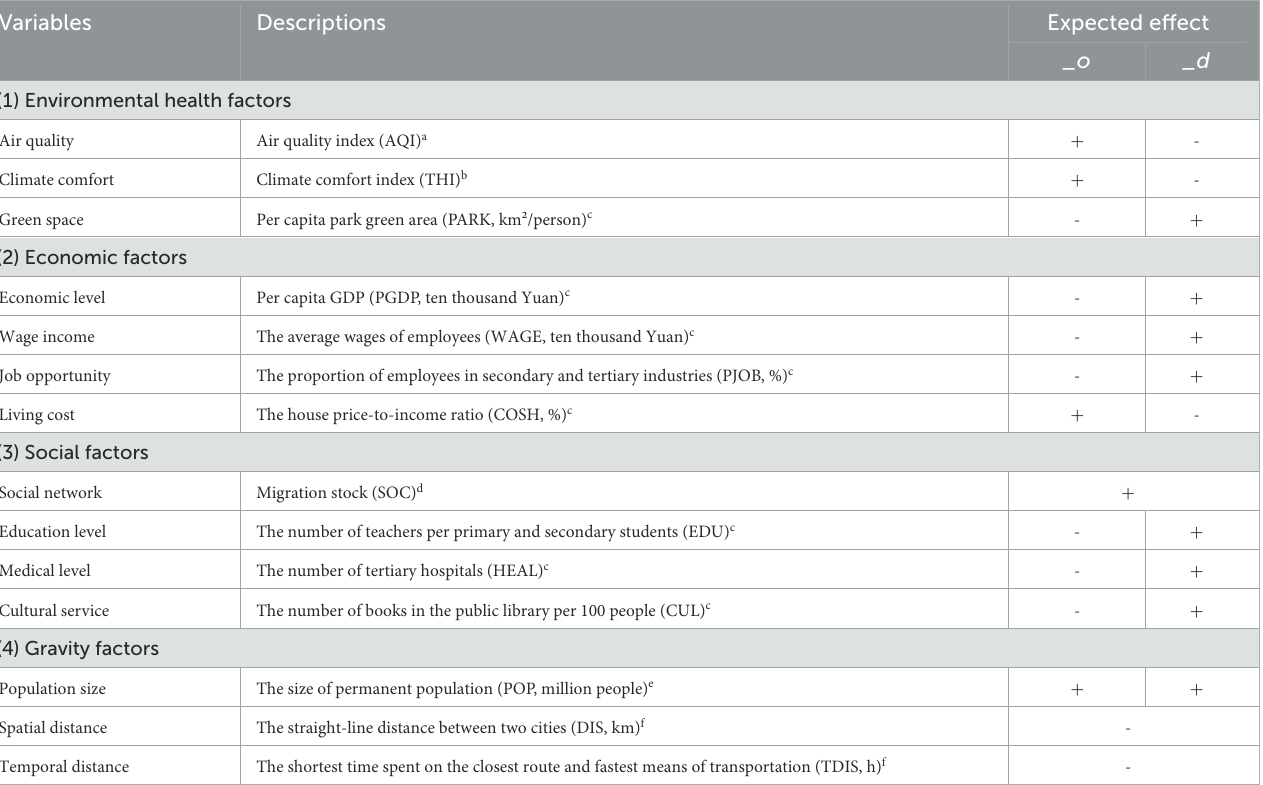
TABLE 1 The variables system of influencing factors of inter-city population